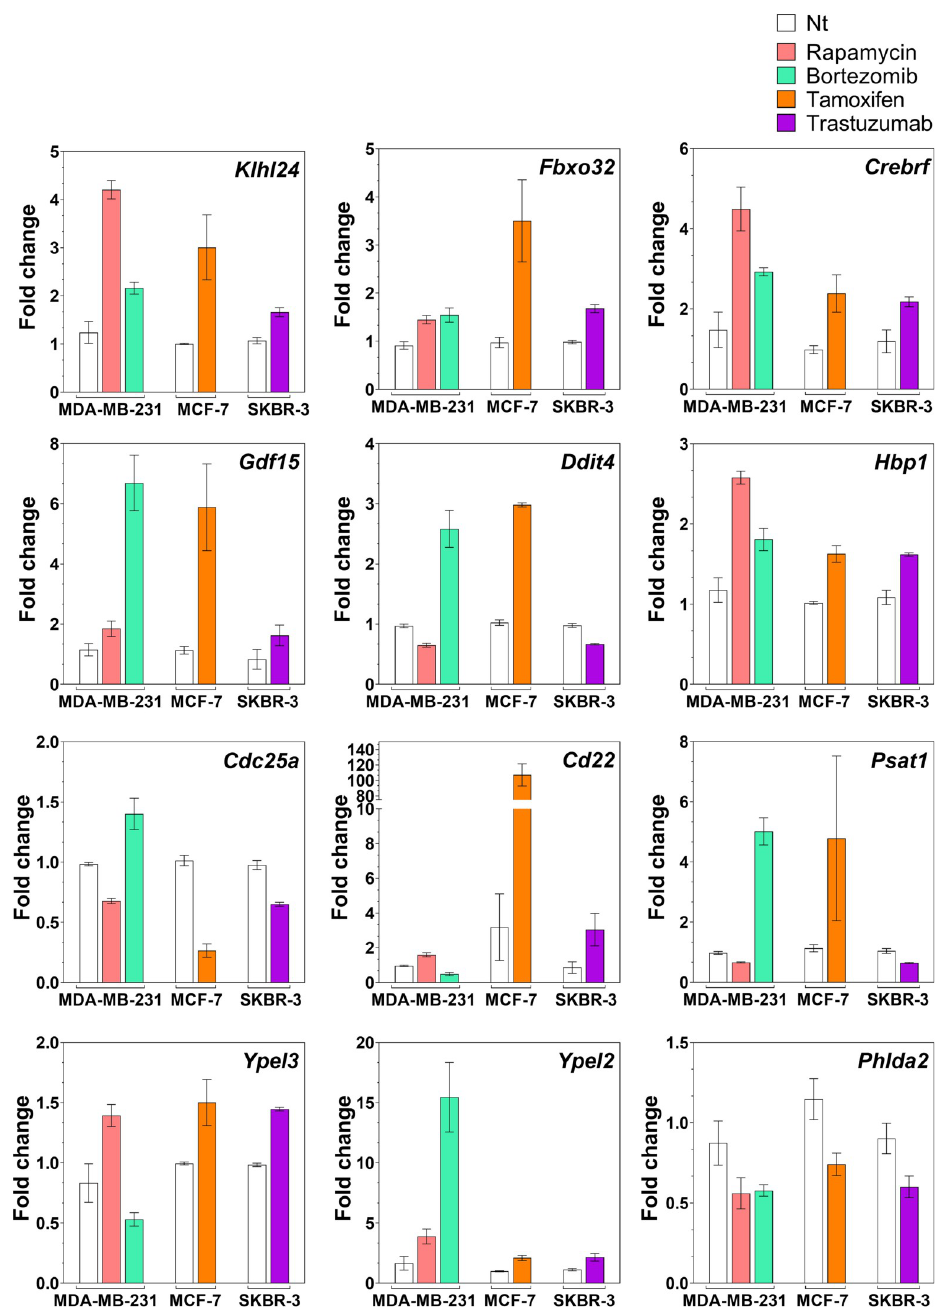
Fig 2. RNA sequencing data on the drug-independent cell-independent signature. Relative expression of the 12 mRNAs plotted as fold change over the non-treated for each drug and cell line. The mRNAs were selected from the lists of differentially expressed genes between no treatment and drug treatment in each group with p � 0.05 and -0.5 � log 2 FC � +0.5. FC = fold